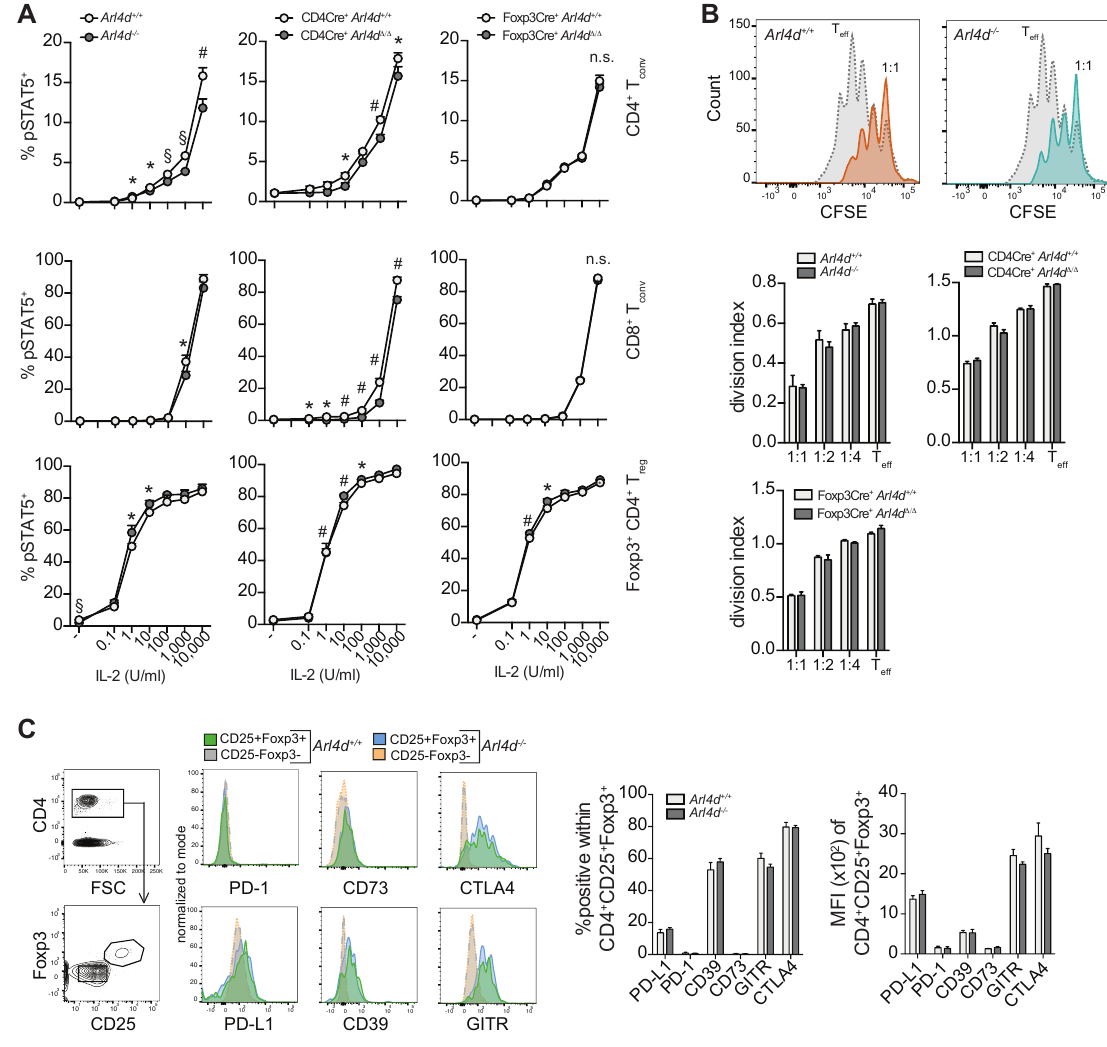
Figure 5. IL-2 receptor signaling and T reg suppressive function in the presence or absence of Arl4d. ( A ) Splenocytes from the indicated mice were isolated and incubated for 10 (cid:48) with rhIL-2 at the indicated concentrations. Subsequently, cells were fixed and stained for CD8 α , CD4, CD25, Foxp3, and pSTAT5 antibodies. The percentages of pSTAT5 + cells were determined in CD8 α + T conv , CD4 + T conv , and CD4 + Foxp3 + T reg cells. ( B ) Splenic CD4 + CD25 high T cells were sorted from mice as indicated. These were incubated with CFSE-labeled wild-type CD4 + T cells at the indicated T reg /T eff ratios in the presence of α CD3 ε / α CD28-coated beads. After 72 h, the proliferation of the CFSE + CD4 + T cells was determined by flow cytometry. Histograms show an exemplary plot from CD4 + Teff incubated with either CD4 + CD25 high T reg from Arl4d +/+ , Arl4d − / − mice at a 1:1 ratio, or, as a control, CD4 + T eff